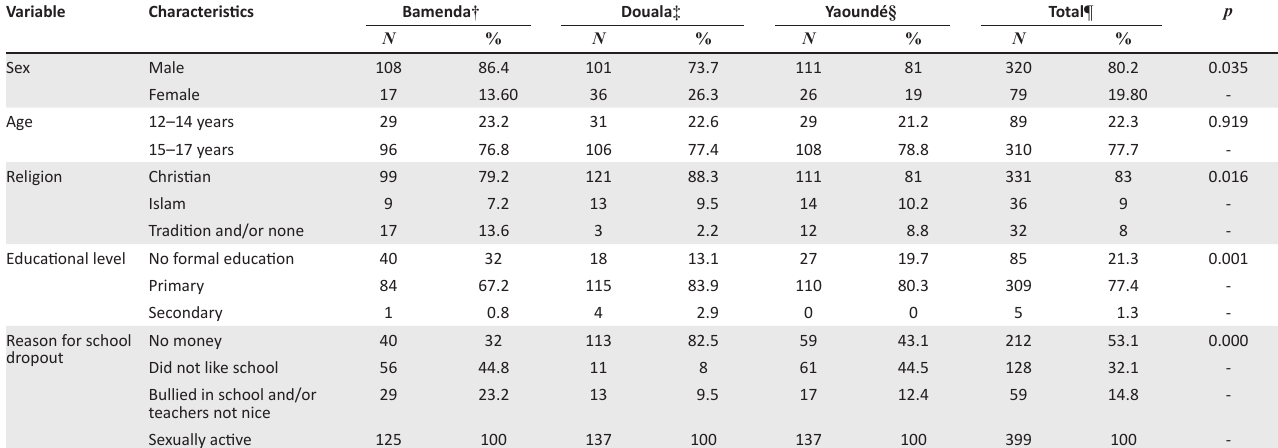
TABLE 1: The demographic characteristics of participants by city. Variable Characteristics